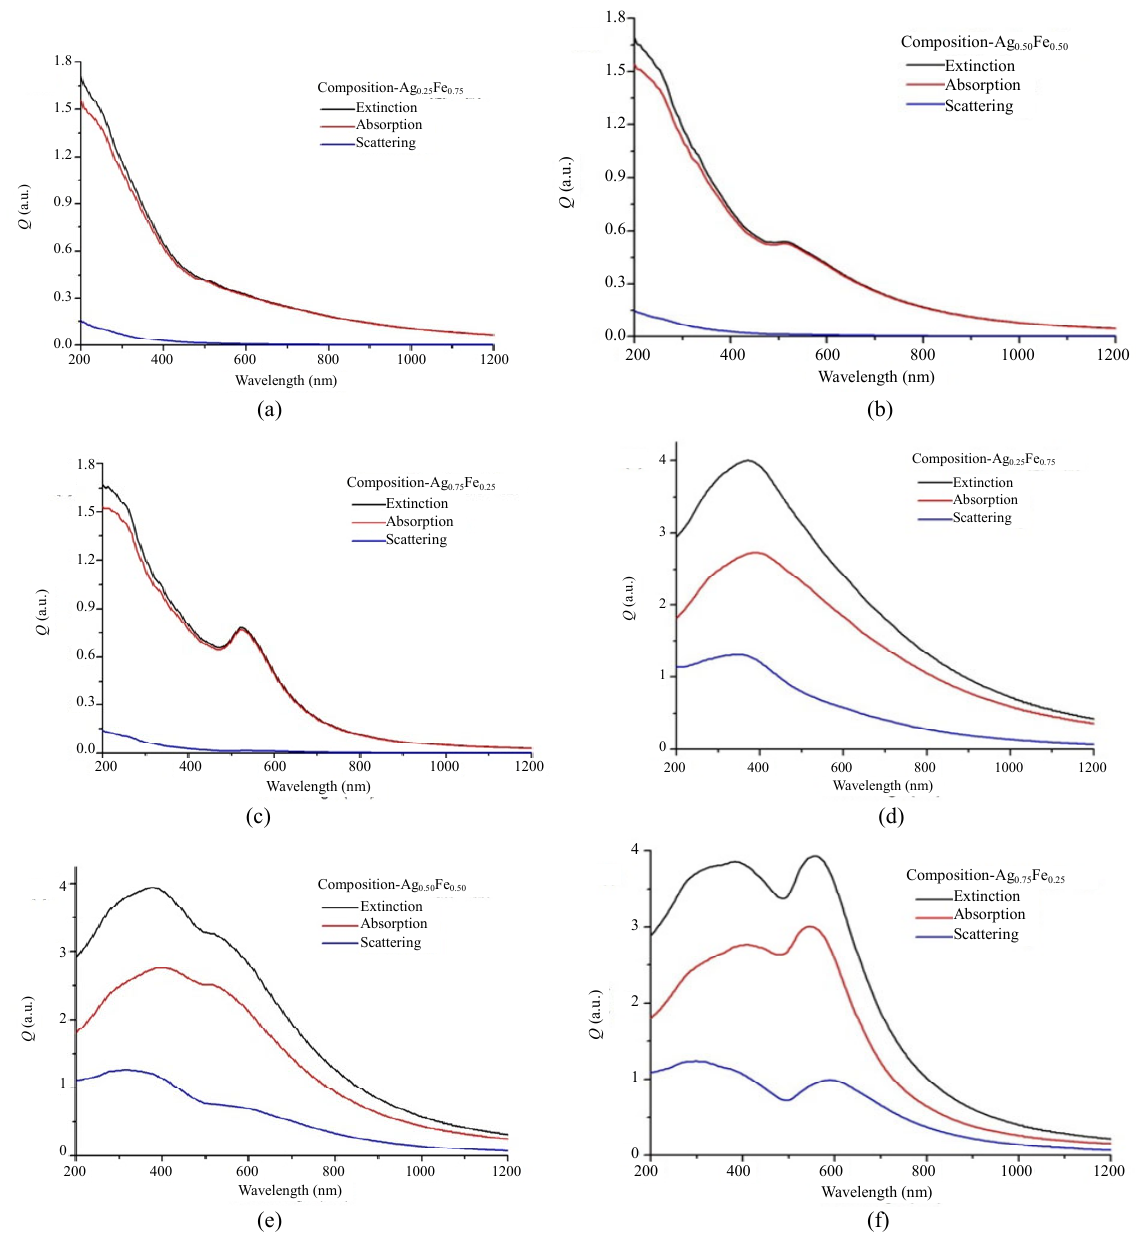
Fig. 4 Extinction, absorption, and scattering spectra for Au-Fe bimetallic nanoparticles with different alloy compositions with particle size of 20 nm in (a), (b), and (c) and particle size of in 70 nm (d), (e), and